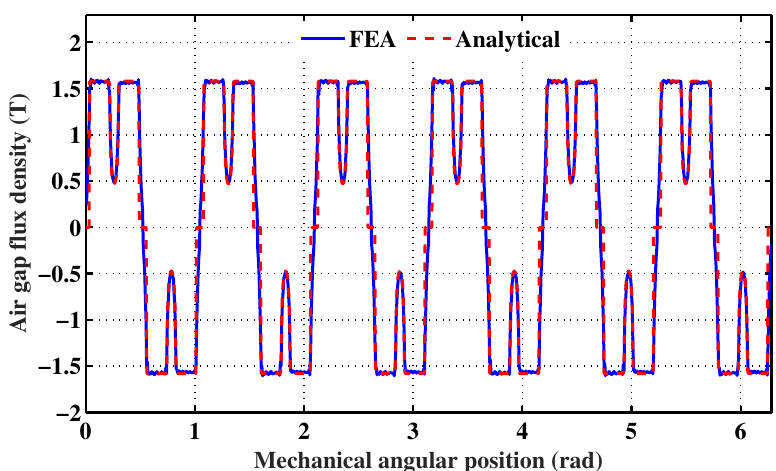
Figure 4. PM flux density spatial repartition with the stator slotting effect taken into account, assuming a slottless rotor, and without correction.